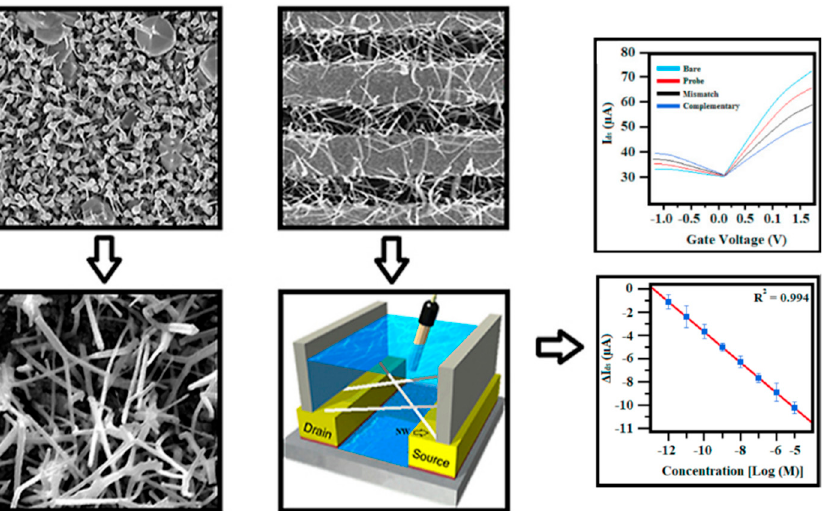
Figure 11. The morphological and crystal structure characterization of the fabricated ZnO NPs doped MoS 2 nanowires (NWs)-based FET biosensor for HBV DNA detection. The doped MoS 2 NWs device showed differential transfer characteristics for bare FET and after the immobilization of various targeting DNA sequence concentrations. The drain-source current changes showed a linear range against concentrations from 1 pM to 10 μ M. The figure is adopted and reprinted with permission from Ref. [115]. Copyright Elsevier Ltd. (2021).